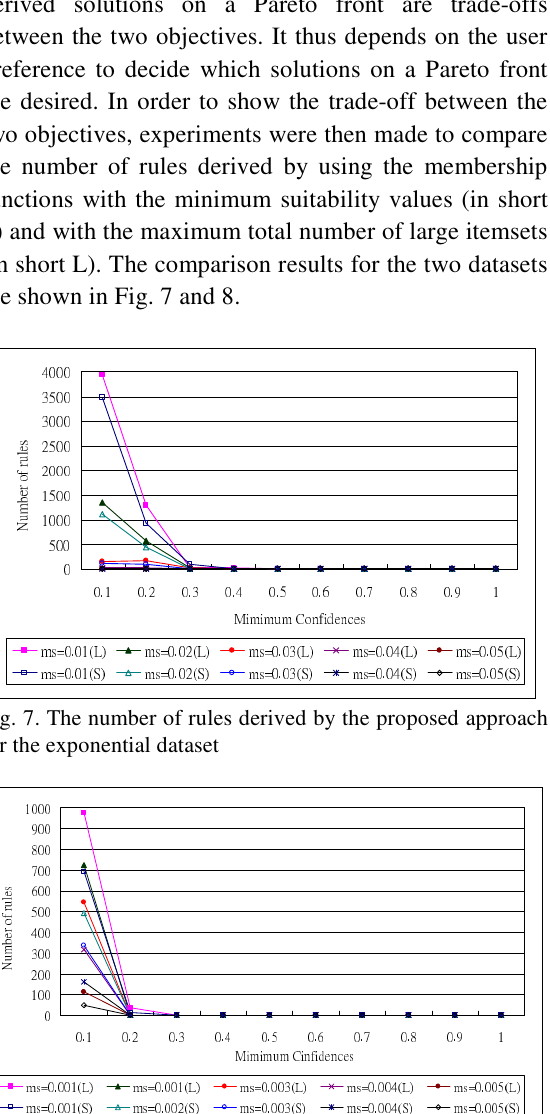
membership functions with the maximum total